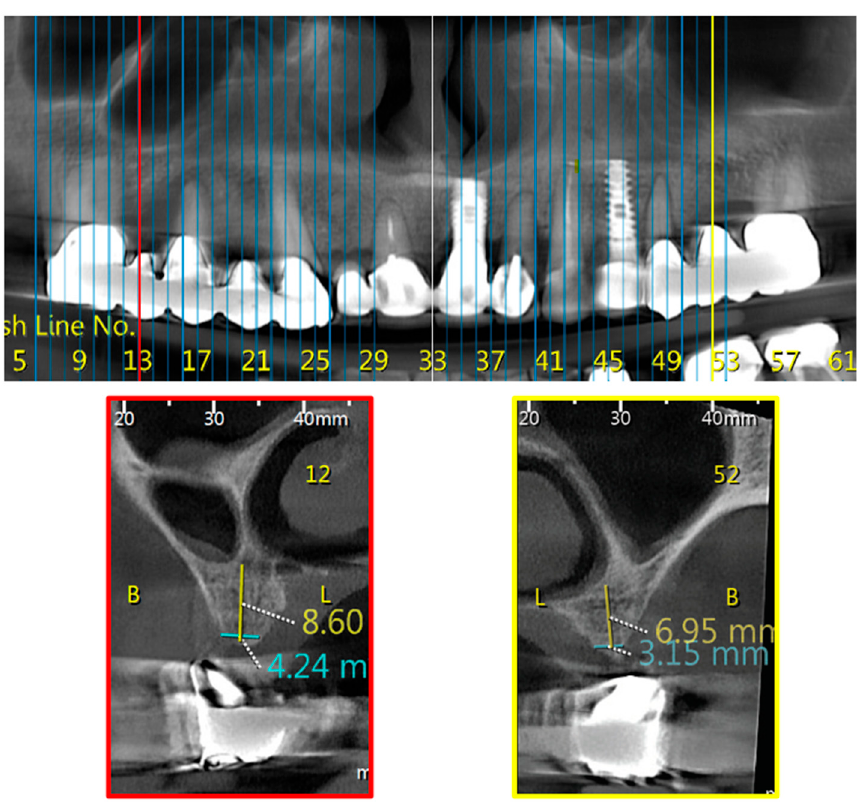
Figure 3. Bilateral Class 3; Upper part—CBCT panoramic reconstruction; Lower part—from right to left—CBCT cross sections: cross section number 52—demonstrate left nasal and maxillary sinus “border cross section”, which is located distal to the mesial edge of the 1st molar, defined as Class 3; cross section number 12—demonstrate right nasal and maxillary sinus “border cross section”, which is located distal to the mesial edge of the 1st molar, defined as Class 3. B, buccal; L, lingual.